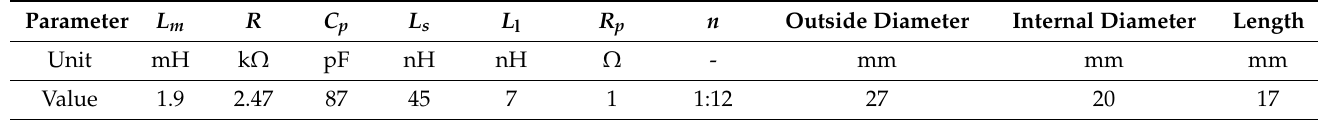
Table 3. Measured parameters of the HFCT II.